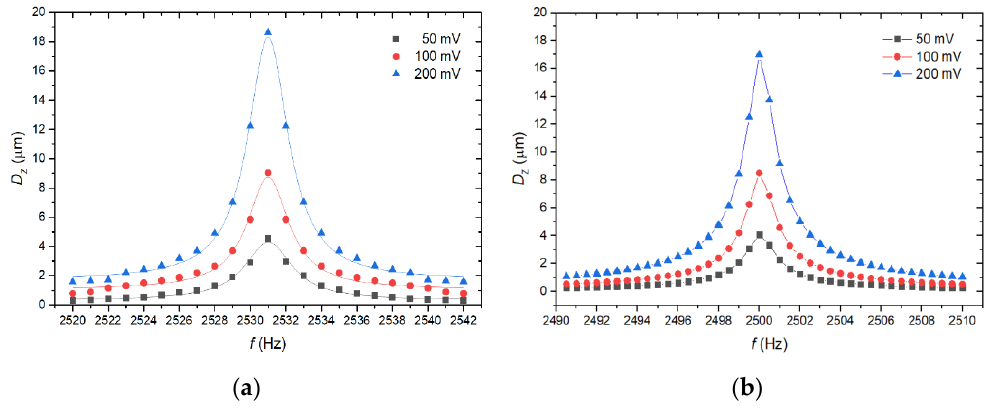
Figure 8. ( a ) Measured D Z at f r = 2520 Hz with various V AC . ( b ) The results of FEM simulations for the same V AC bias.